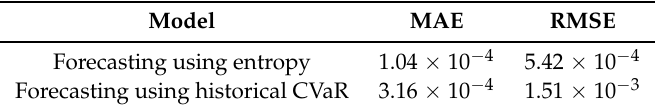
Table 5. Backtest results of daily CVaR at the significance level α =